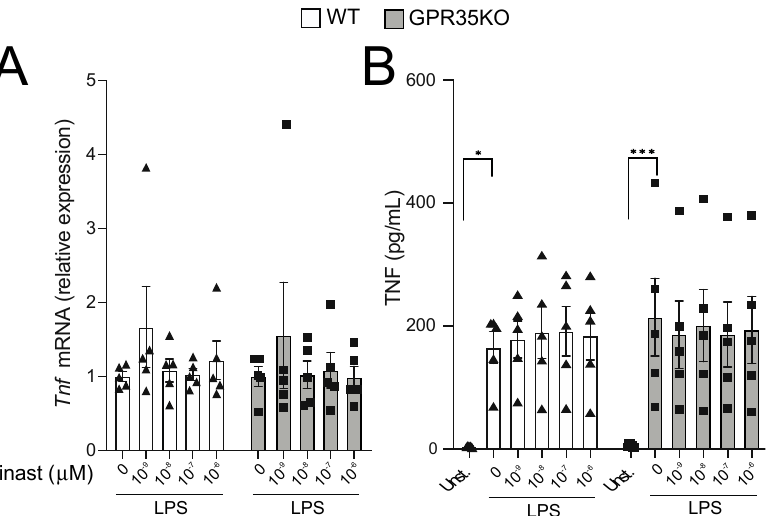
Figure 5. The effect of GPR35 ligation with zaprinast to TNF production on BMDMs stimulated with LPS. ( A ) The relative mRNA expression of Tnf in GPR35KO and WT BMDM, co-incubated for 2 h with increasing doses of zaprinast and 0.1 ng/mL LPS; n = cells from 5 mice/group. ( B ) Levels of TNF secreted by BMDMs from GPR35KO and WT mice, co-incubated for 2 h with increasing doses of zaprinast and 0.1 ng/mL LPS; n = cells from 5 mice/group. Results are mean ± SEM. No significant differences were observed; Friedman test with Dunn’s post-test. (*) p < 0.05, (***) p < 0.005.